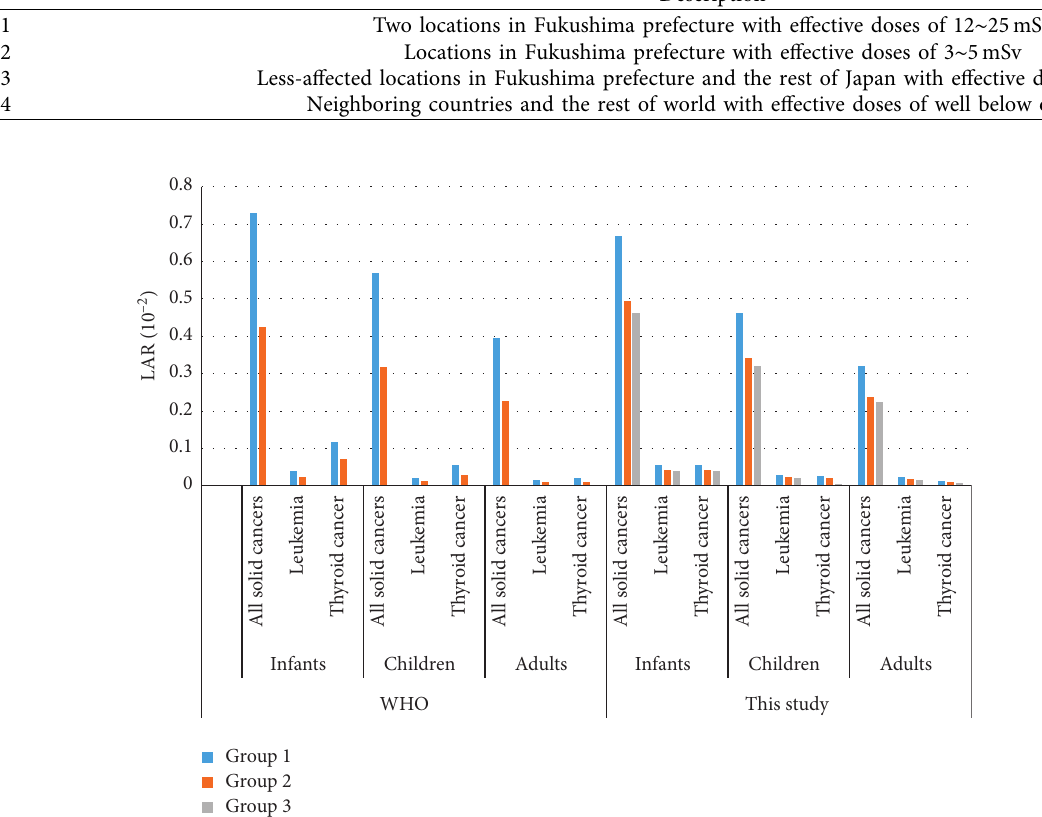
Table 4: Group classification considered by WHO study. Group Description